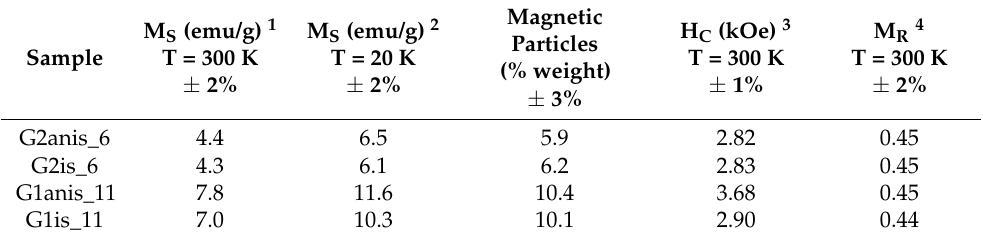
Table 7. Magnetic data relative to the composite geopolymer samples, labeled as in column